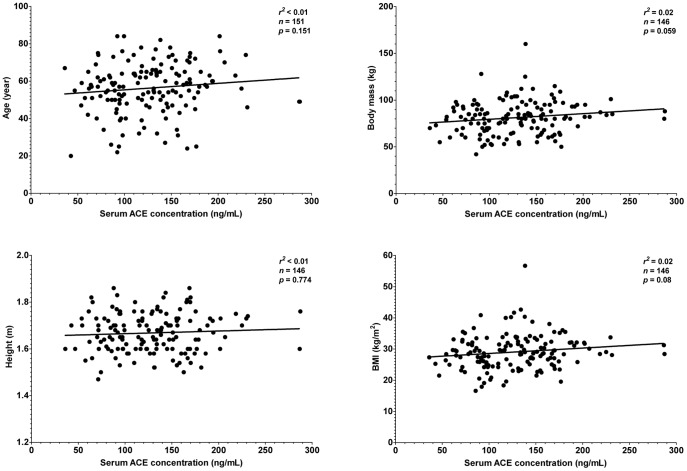
There is no relationship between morphometric parameters and serum ACE concentration.Age, body mass, height and body mass index of the patients involved in the studies (n = 151) are plotted as the function of the measured serum ACE concentration. Points were fitted by a linear regression to reveal the potential correlation between the plotted parameters. Parameters of the fitting are shown in each graph. The normal range for BMI is 18.5–25 kg/m2.